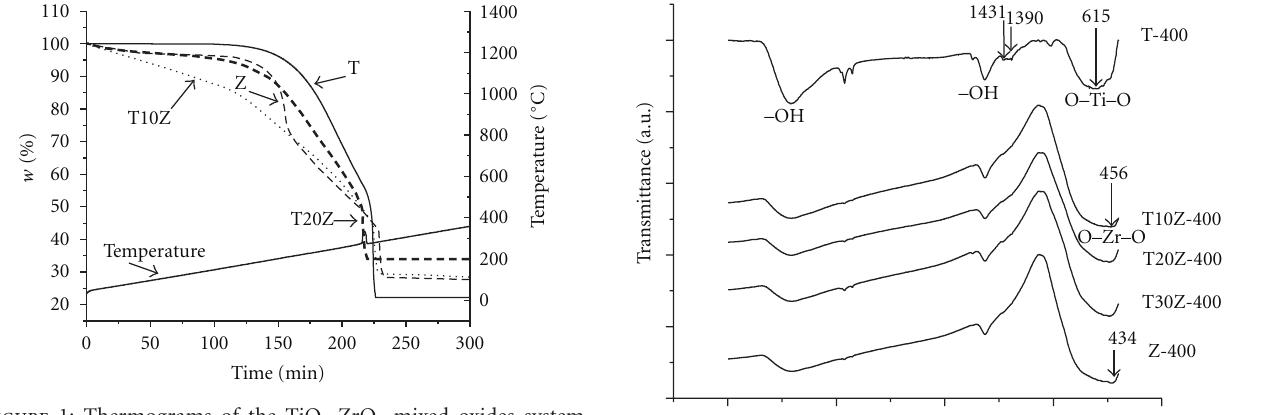
Figure 1: Thermograms of the TiO 2 -ZrO 2 mixed oxides system (T10Z-400, T20Z-400, and Z-400 samples).